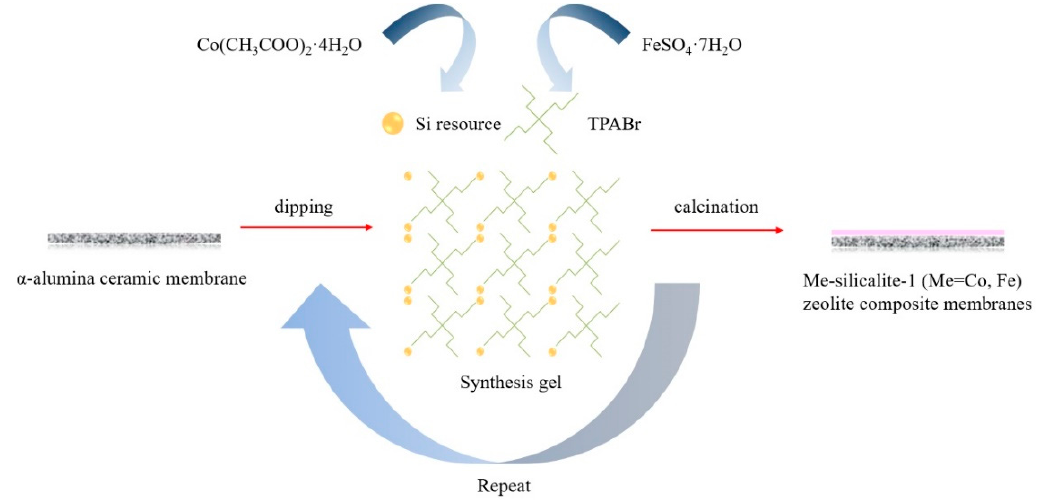
Figure 8. Fabrication procedures of the Me-silicalite-1 (Me = Co and Fe) zeolite composite mem-